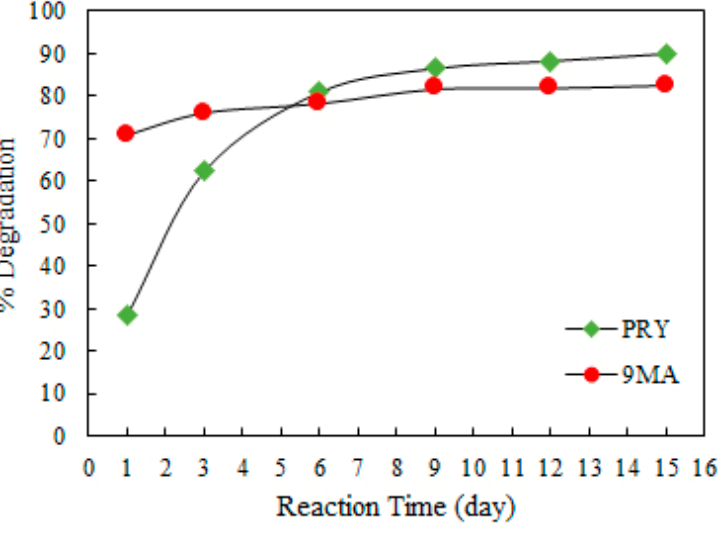
Figure 4. WLP (0% of H 2 O 2 ) efficiency in degradation of PAHs obtained in 0, 1, 3, 6, 9, 12, and 15 days.